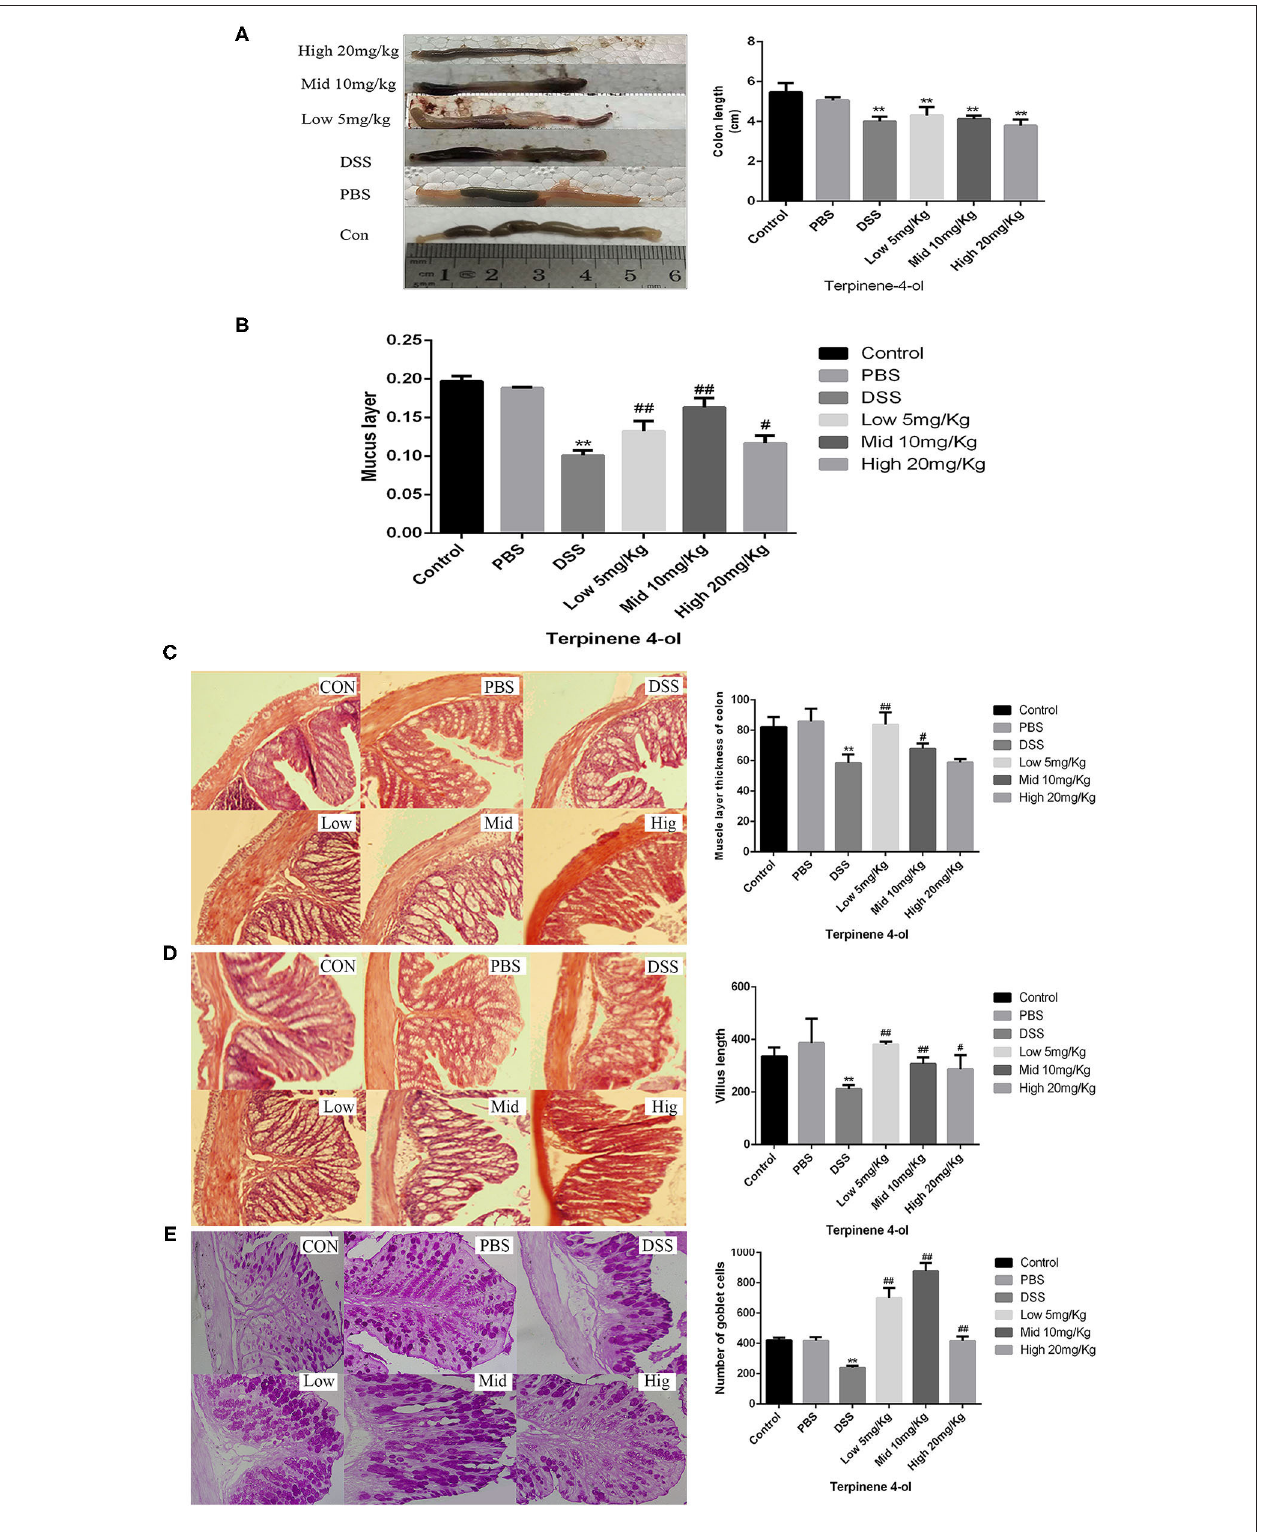
FIGURE 8 | Effect of terpinen-4-ol (TER) treatment on colonic histopathology and the intestinal mucosal layer thickness in dextran sulfate sodium (DSS)-induced colitis. Effect of TER treatment on the colon length (A) , mucus layer thickness (B) , muscle layer thickness (C) , villus length (D) , and the number of goblet cells (E) in mice with DSS-induced colitis. ** and ## display similar means with above mentioned.